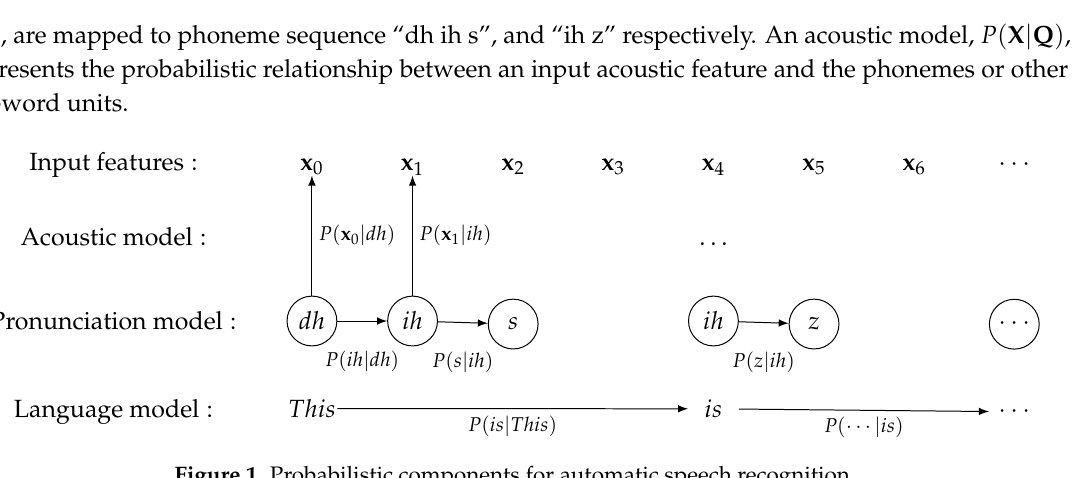
Figure 1. Probabilistic components for automatic speech